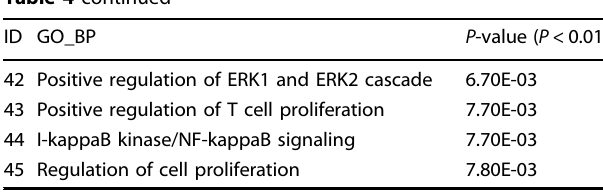
Shortest paths length between drug targets and symptom genes